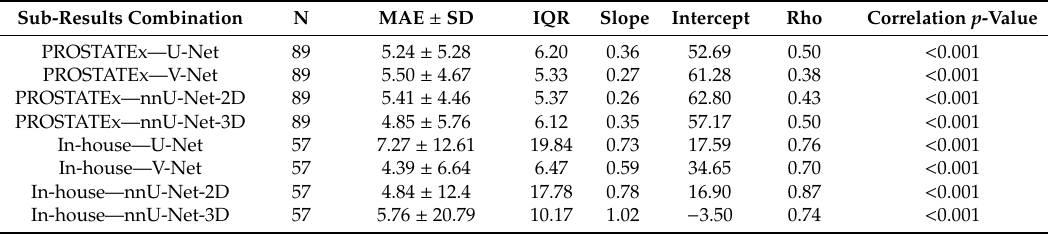
Table 2. Sub-results from the tested General model performance